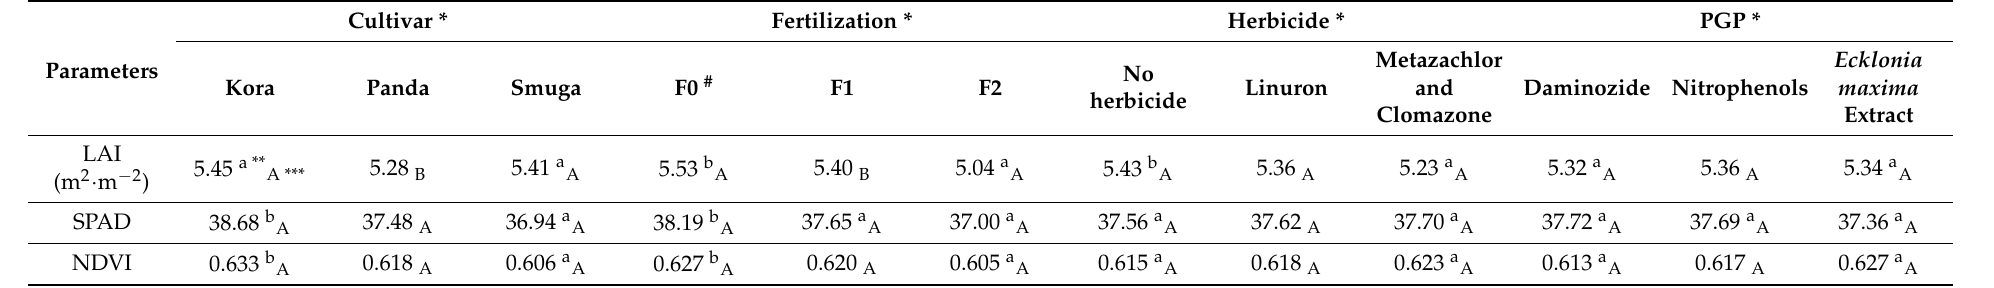
Table 6. LAI, SPAD, and NDVI of common buckwheat under the influence of cultivar, calcium cyanamide fertilization, herbicide use, and PGP application.